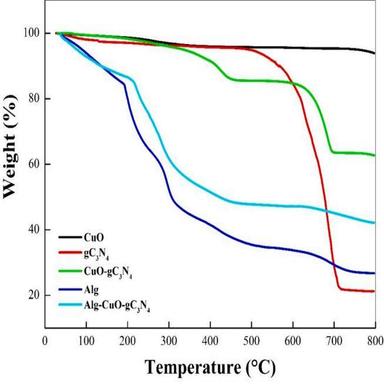
TGA curves of Alg, CuO, gC3N4, CuO-gC3N4 and Alg/CuO-gC3N4.